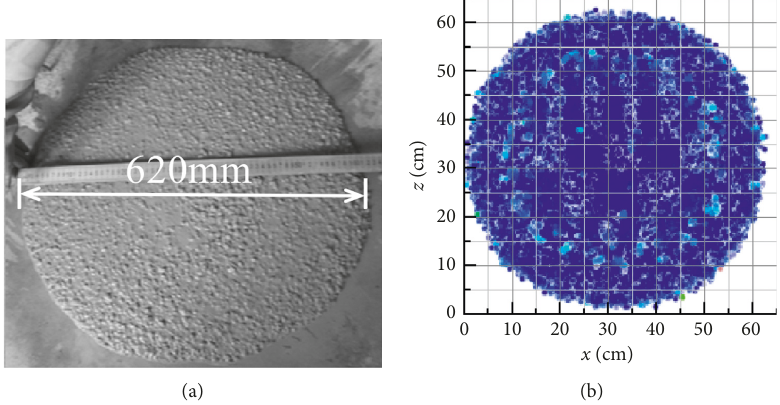
Figure 5: Final spread of the slump test. (a) Experiment [24] and (b) simulation.